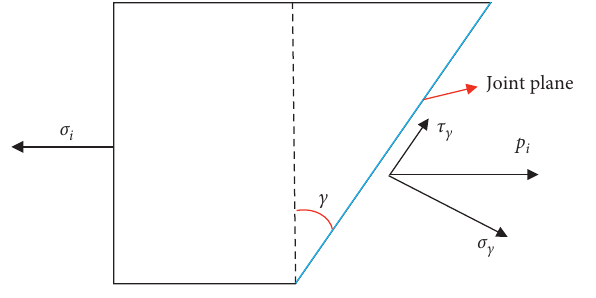
Figure 12: Tensile stress decomposition.